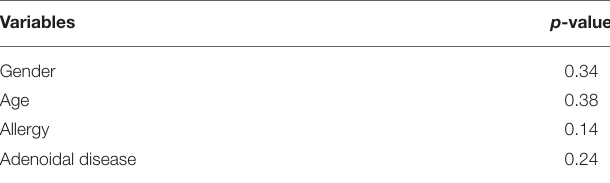
TABLE 3 | Results of univariate logistic regression analysis.